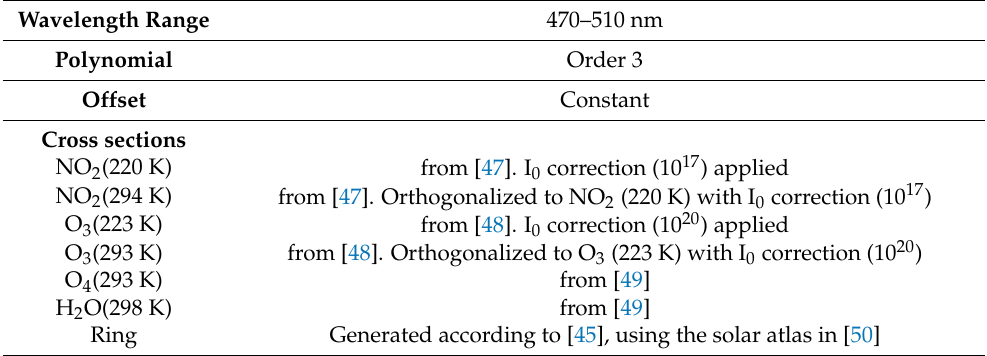
Table 2. Main QDOAS settings used for NO 2 and O 3 SCDs